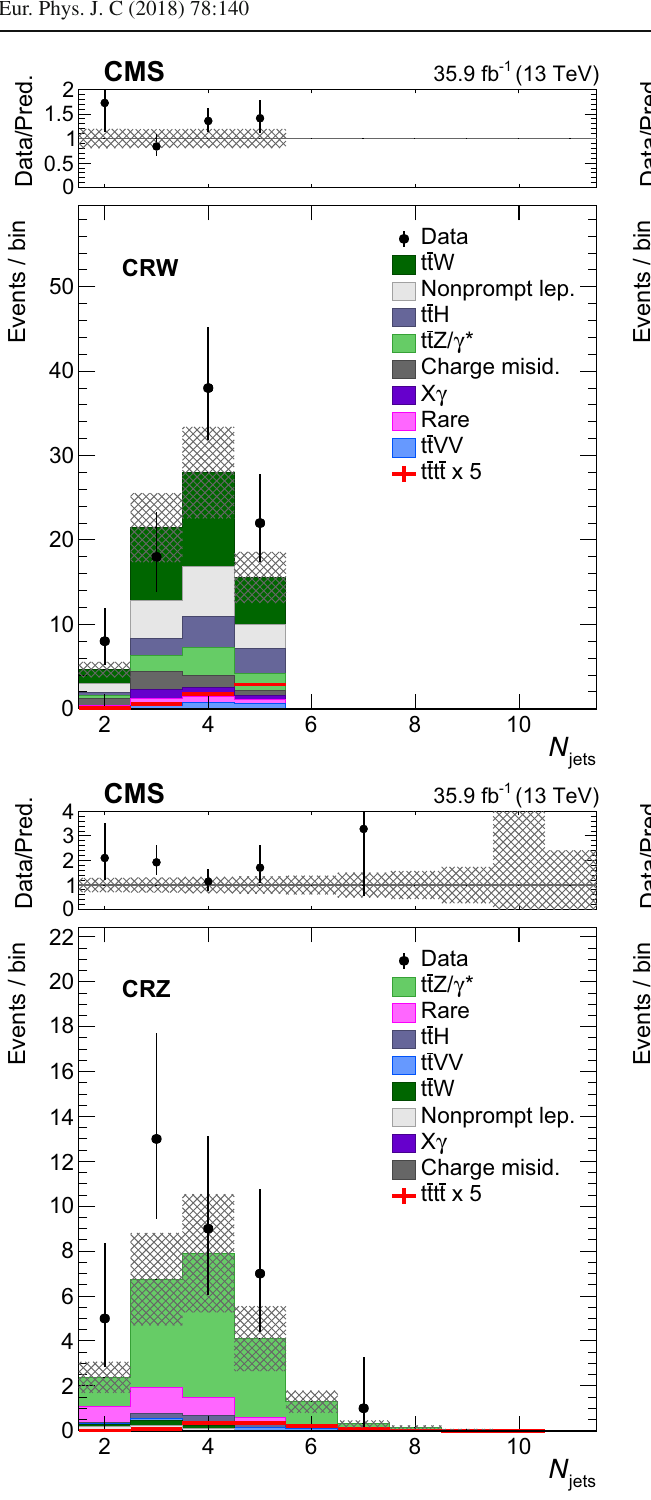
Fig. 3 Distributions in N jets and N b in ttW (upper) and ttZ (lower) control regions, before fitting to data. The hatched area represents the uncertainty in the SM background prediction, while the solid line rep- resents the tttt signal, scaled up by a factor of 5, assuming the SM cross